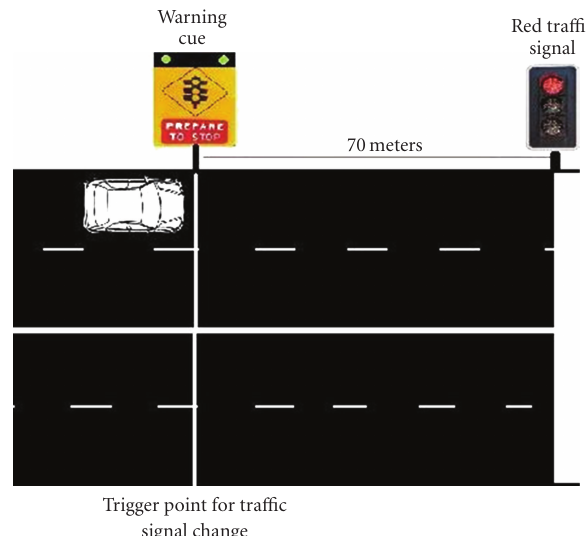
Figure 1: Example of the Cueing Driving Event. Warning cue was either Valid (red flashing lights) or Invalid (green flashing